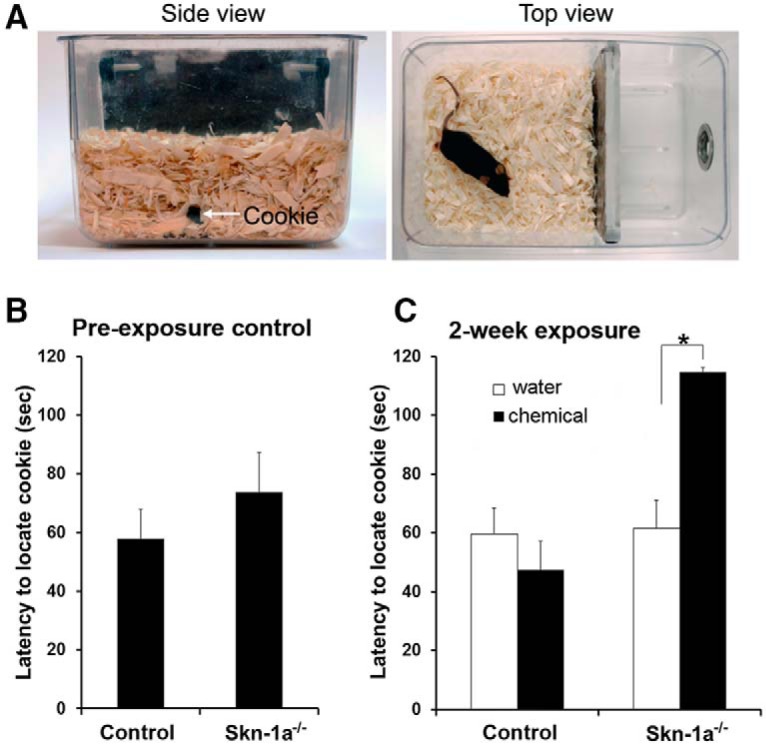
Impaired olfactory ability to locate buried food in Skn-1a-/- mice after chemical exposure. A, Photographs of the experimental setting for the buried food test. Left panel: side view, showing 5- to 6-cm wood chip bedding over a buried cookie piece (indicated by an arrow). Right panel: top view before a mouse began to search for the piece of cookie. B, C, Plot of the average time (latency) required for mice to locate the buried cookie. The latency was not significantly different between control and Skn-1a-/- mice housed under our standard conditions (B; n = 14 and 13, WT and Skn-1a-/-, respectively). After chemical exposure, Skn-1a-/- mice took a significantly longer time to locate the buried cookie compared with the water-exposed group (*p < 0.05, t test, n = 14 and 9, respectively). There was no difference between the water- and chemical-exposed groups of control mice (C; n = 9 and 12, respectively).